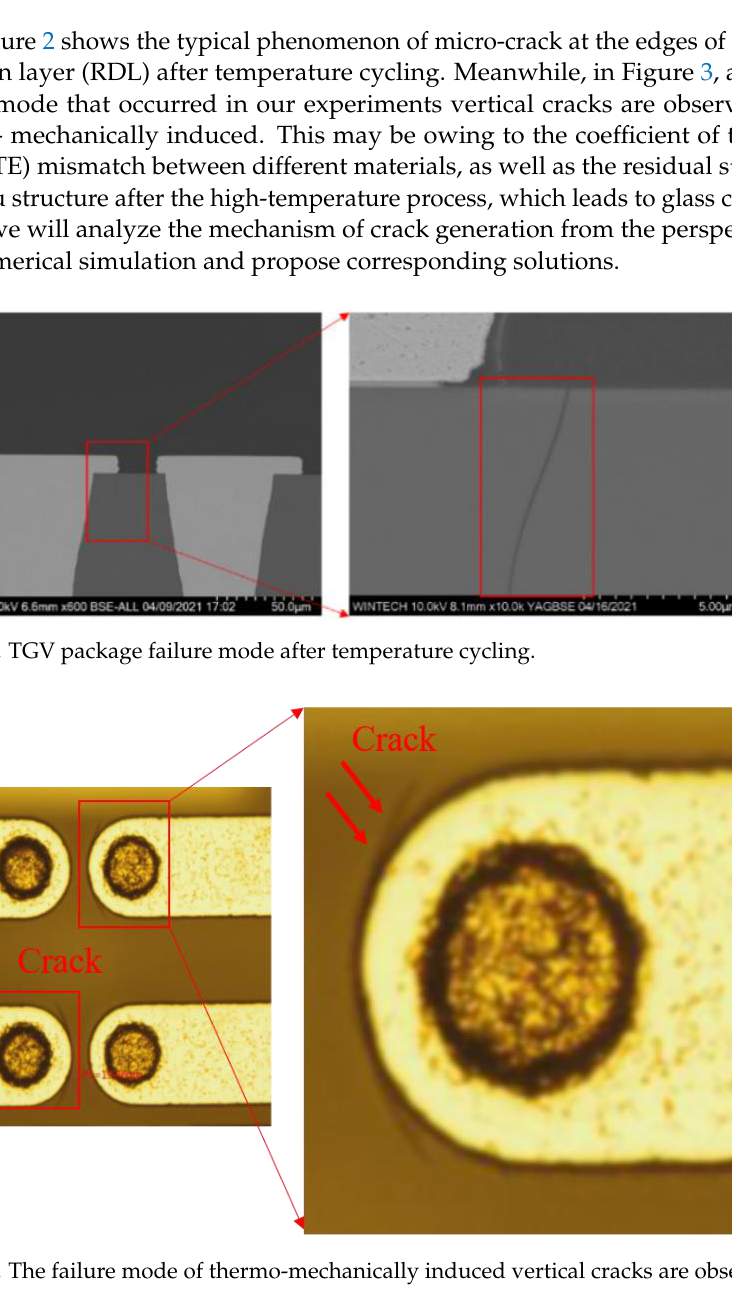
Figure 3. The failure mode of thermo-mechanically induced vertical cracks are observed.